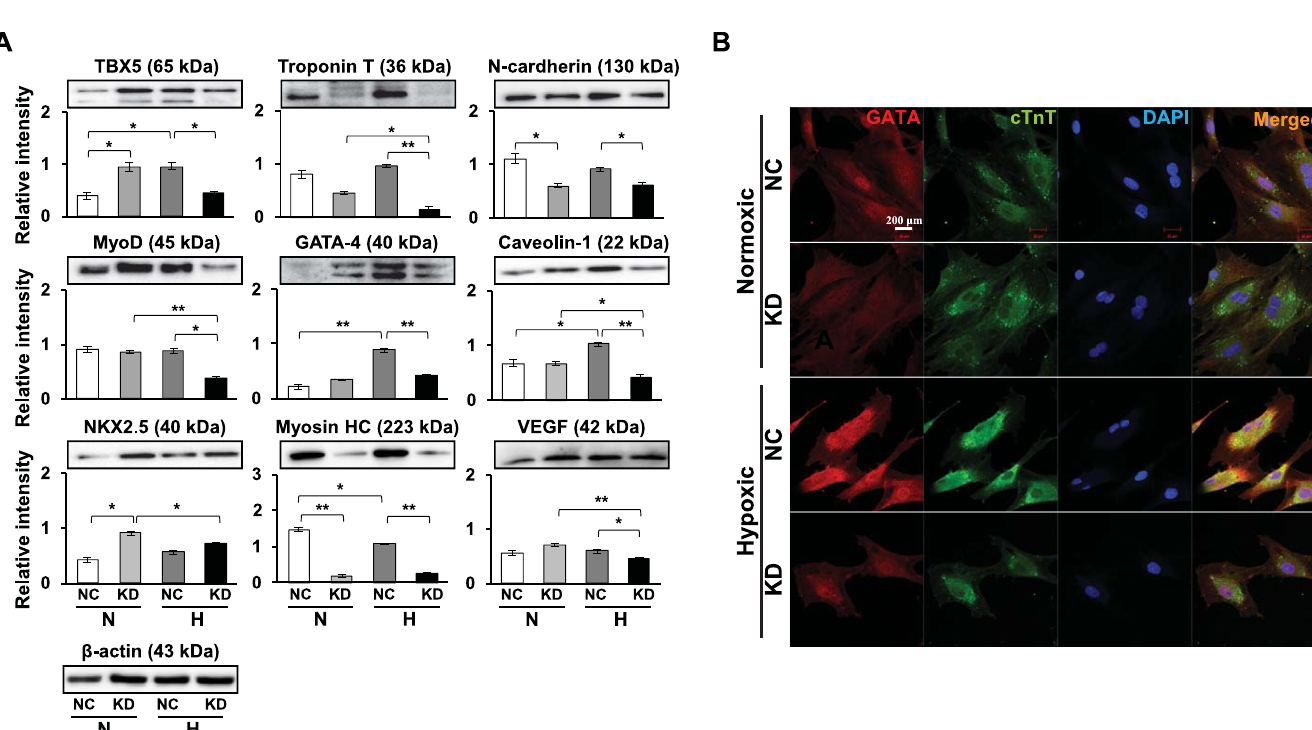
Fig 4. Effects of Sgsm3 knockdown on cardiogenic marker expression in rat MSCs. Changes in cardiogenic marker expression upon Sgsm3 knockdown in MSCs were measured via immunoblot analysis (A) and immunocytochemical staining (B). Band intensity was measured as the area density and analyzed in ImageJ and relative intensity levels indicate protein levels normalized to the β -actin levels (A). The nuclei were stained with DAPI (B). Scale bar = 200 μ m. The data are representative of two independent experiments. Significant differences between groups were determined via ANOVA, with p values indicated as � p < 0.05 and �� p < 0.01. N, normoxia; H, hypoxia; NC, negative control cells; KD, knockdown cells.